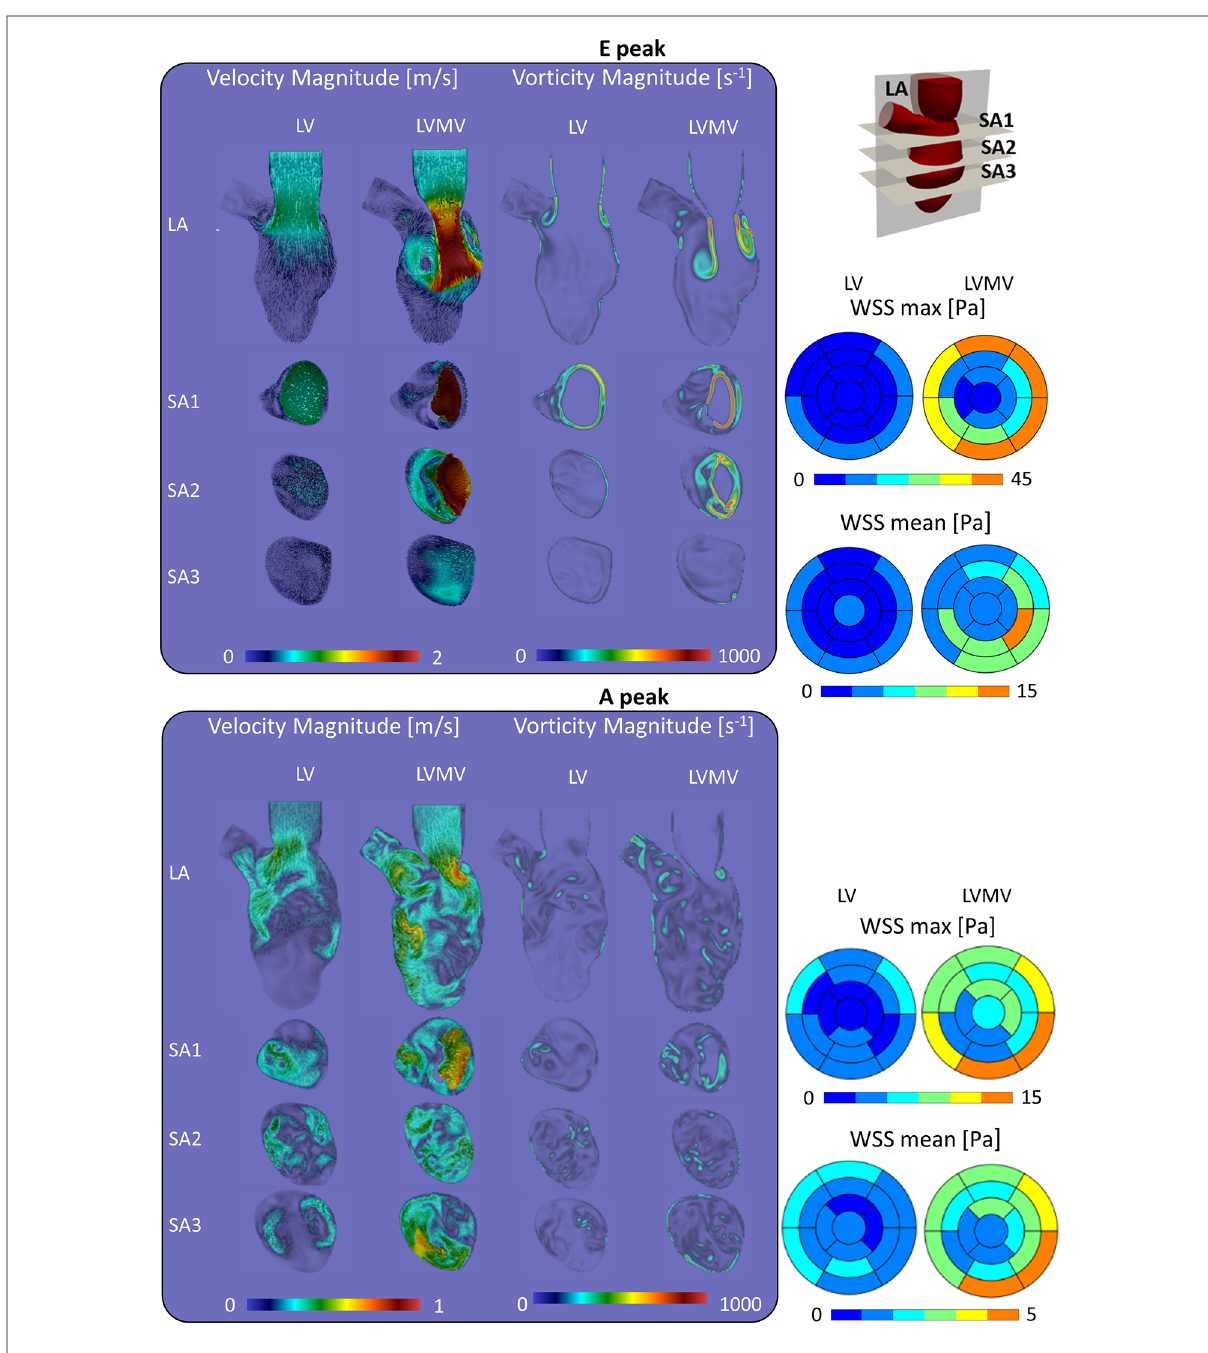
FIGURE 7 Impact of the mitral valve in the torsion case on the velocity, vorticity and wall shear stress during the